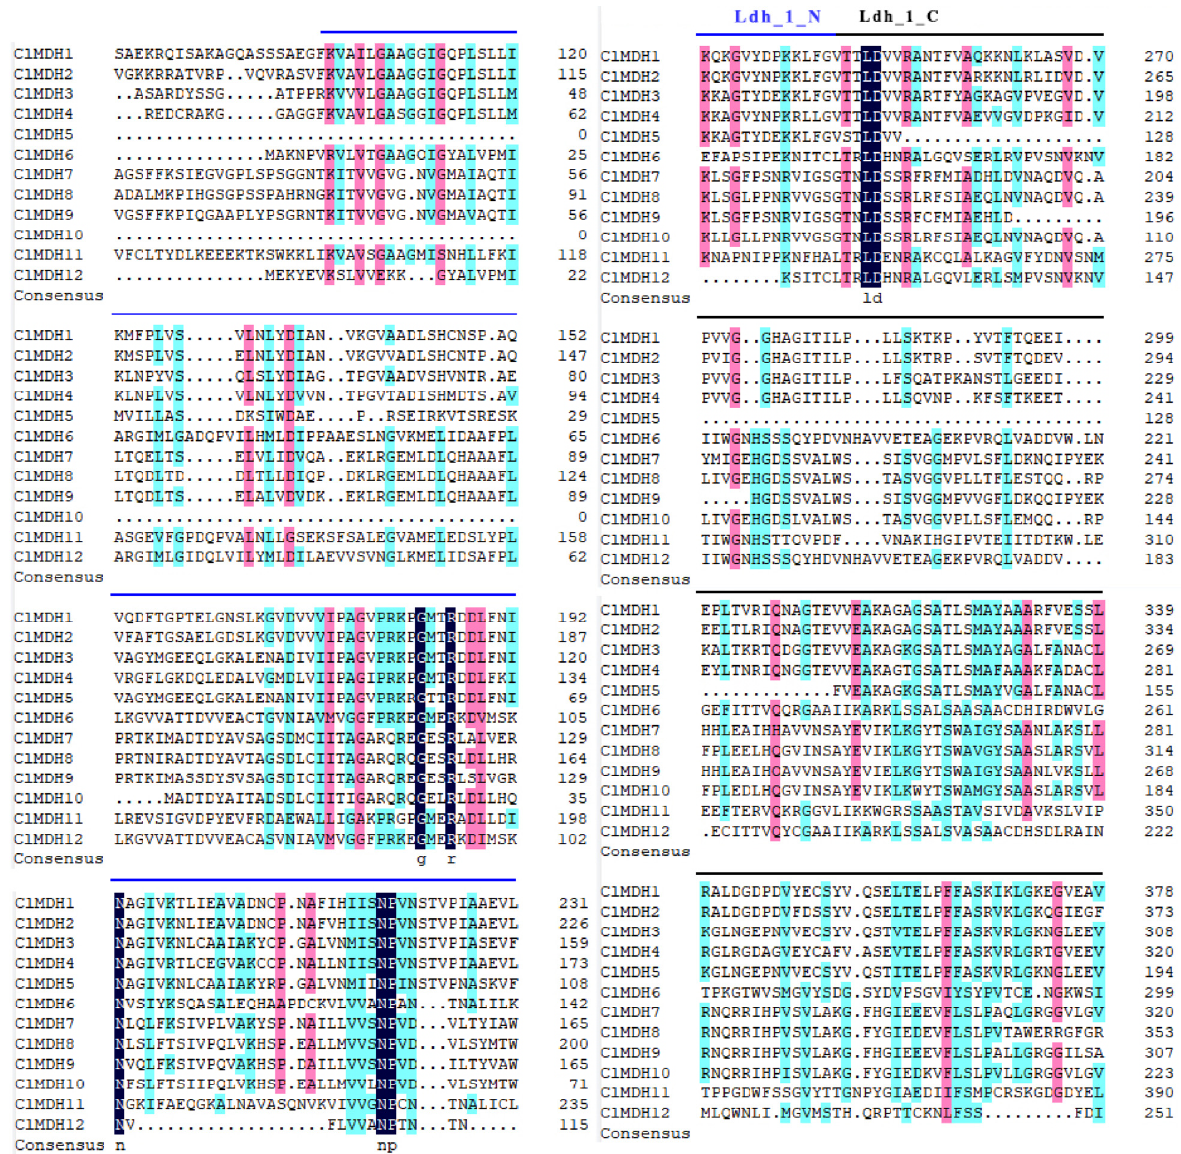
Figure 2. Multiple sequence alignment analysis of Chinese fir ClMDH protein. The black background amino acids represent the same amino acid residues, the pink background amino acids represent similar amino acid residues ( ≥ 75% similarity), and cyan background amino acids represent similar amino acid residues ( ≥ 50% similarity). The Ldh_1_N (NAD-binding) and Ldh_1_C (C-terminal) domains of malate dehydrogenase in the sequence were marked with blue and black lines, respectively.